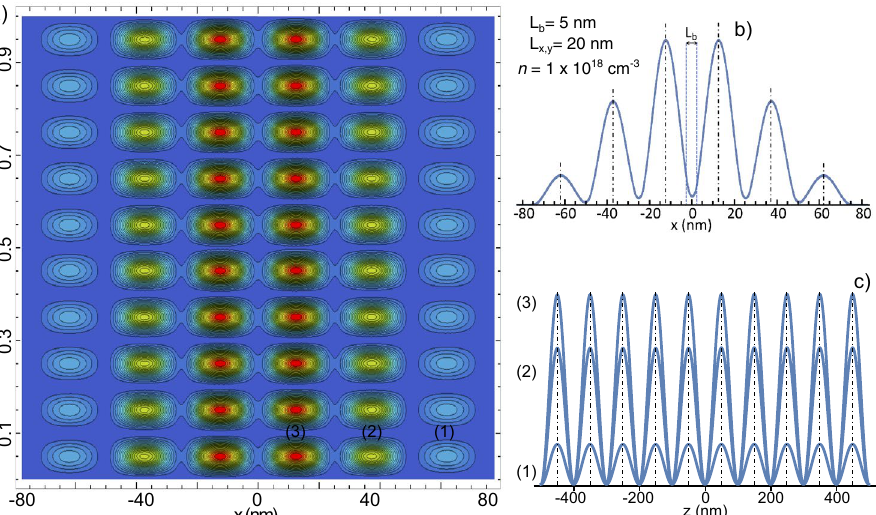
Figure 5. ( a ) Fourth excited state charge distribution for an array of six 1-micron long PNWs of cross section 1 10 18 electrons/cm 3 , and mutual separation L 20 nm, n L x , y = × = density taken along the x direction. ( c ) Profiles taken along the z direction at the x positions where the electron density is maximal; each number indicates the place where the profiles were taken from ( a ).